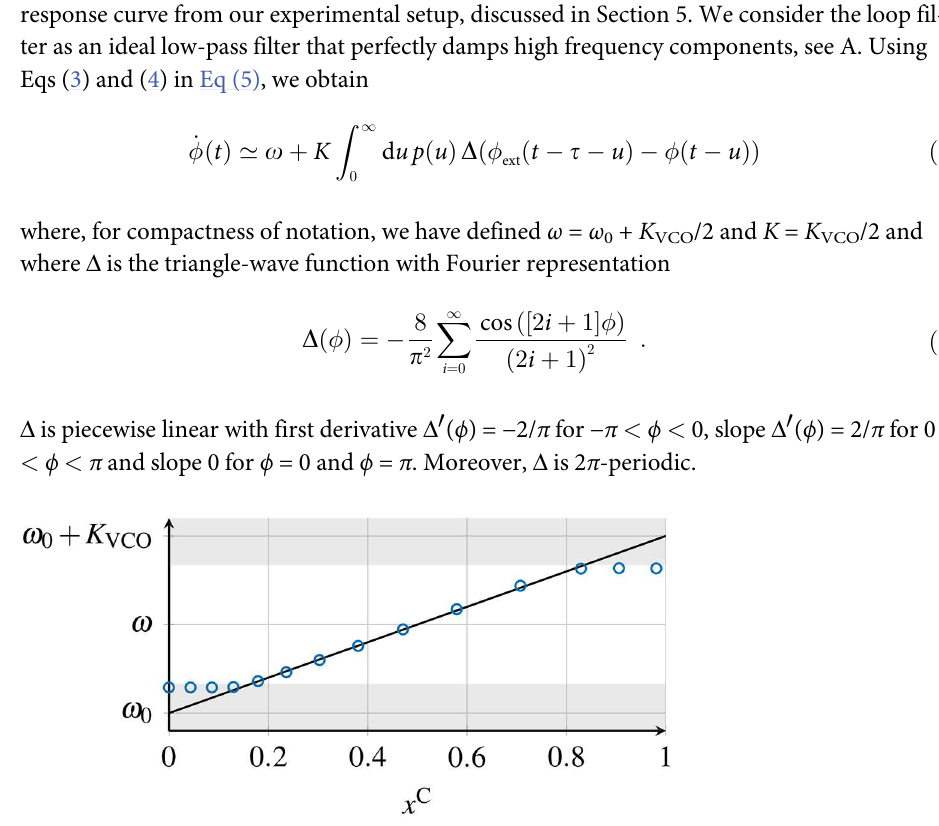
Fig 2. Frequency response of a VCO. Typical dynamic frequencyresponse of a VCO to an externalcontrol voltage x C : linear approximation used in Eq (5) (solid curve), measuredVCO response curve from the DPLLs in our experimental setup (circles). The shadedareas displaythe VCO clippingregion, where the response saturates. © 2015IEEE. Reprinted,with permission, from IEEE Proceedings: Synchronizationof mutually coupleddigital PLLs in massive MIMO systems